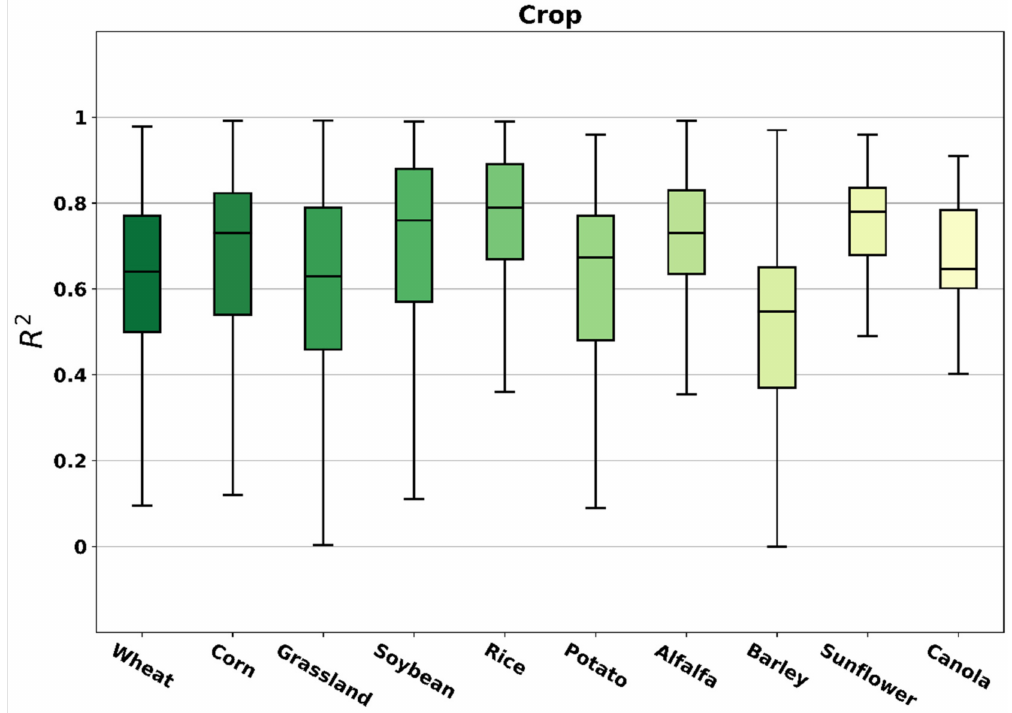
Figure 16. The coefficient of determination (R 2 ) of biophysical retrievals as a function of crop